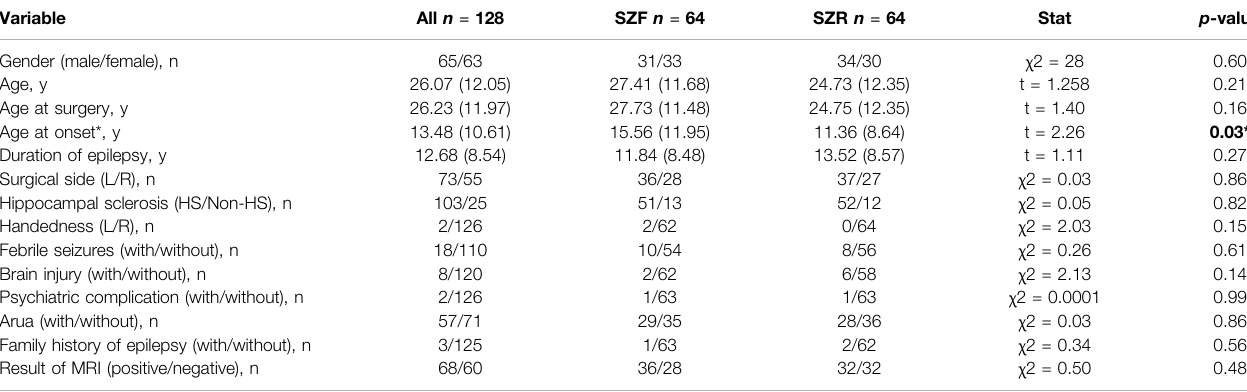
TABLE 1 | Patient clinical characteristics and surgical outcomes.